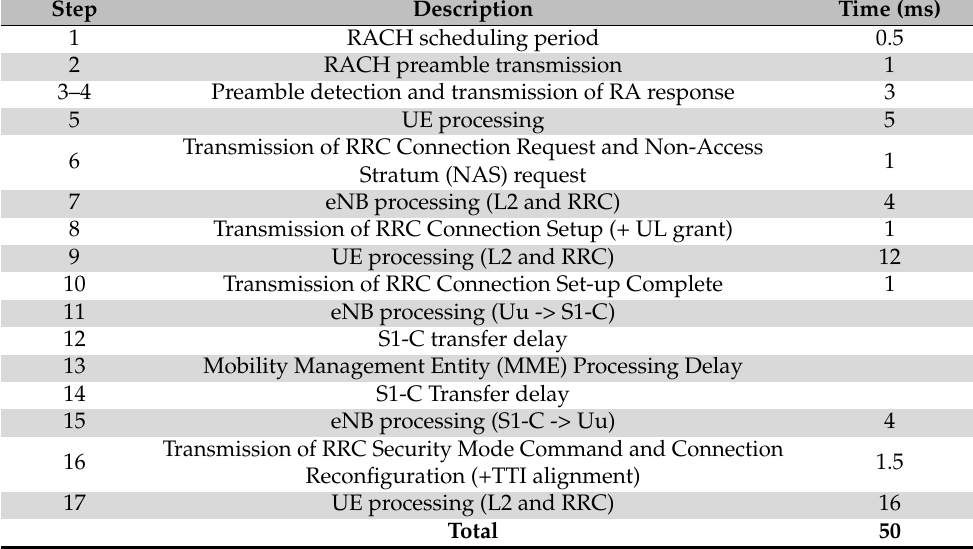
Table 3. Radio Resource Control (RRC) connection establishment in Long-Term Evolution Advanced (LTE-A)